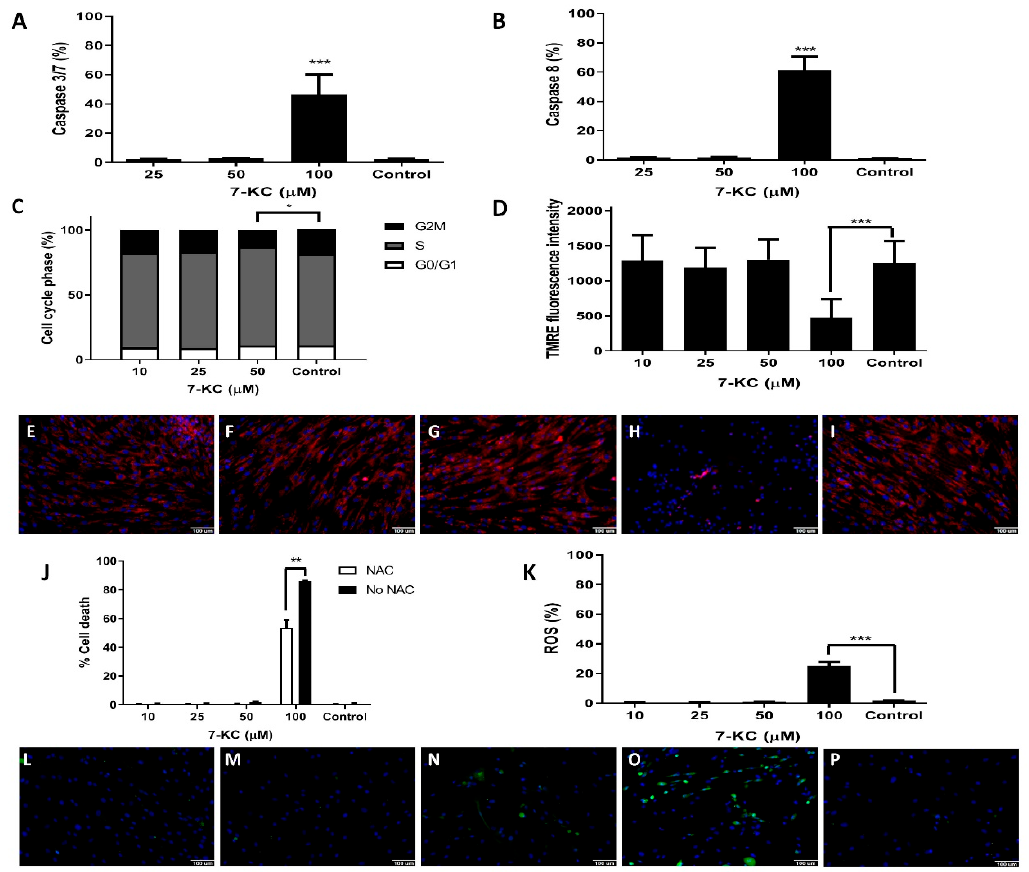
Figure 2. Caspase-3 / 7 and caspase-8 activities, cell cycle phases, mitochondrial transmembrane potential, and e ff ects of reactive oxygen species (ROS) on bone marrow mesenchymal stem cells from patients with acute myeloid leukemia after 24 h 7-KC treatment. A : Percentage of cells with caspase-3 / 7 activity measured by CellEvent Caspase-3 / 7 Green. B : Percentage of cells with caspase-8 activity determined by the Vybrant FAM Caspase-8 Assay Kit. C : Cell cycle phases determined by Hoechst 33342 staining. D : Mitochondrial transmembrane potential evaluated by TMRE. E – I : Representative mitochondrial staining ( E : 10 µ M 7-KC; F : 25 µ M 7-KC; G : 50 µ M 7-KC; H : 100 µ M 7-KC; and I : control). J : Cell death and relationship with ROS. Cells were treated with or without N -acetyl-l-cysteine (NAC) for 4 h following by incubation with 7-KC. Cytotoxicity was evaluated by Hoechst 33342 / propidium iodide staining. K : Percentage of cells producing ROS as evaluated by DCFH-DA. L – P : Representative figures of ROS-producing AML mesenchymal stem cells (LMSCs) ( L : 10 µ M 7-KC; M : 25 µ M 7-KC; N : 50 µ M 7-KC; O : 100 µ M 7-KC; and P : control). Data are mean ± SEM from three